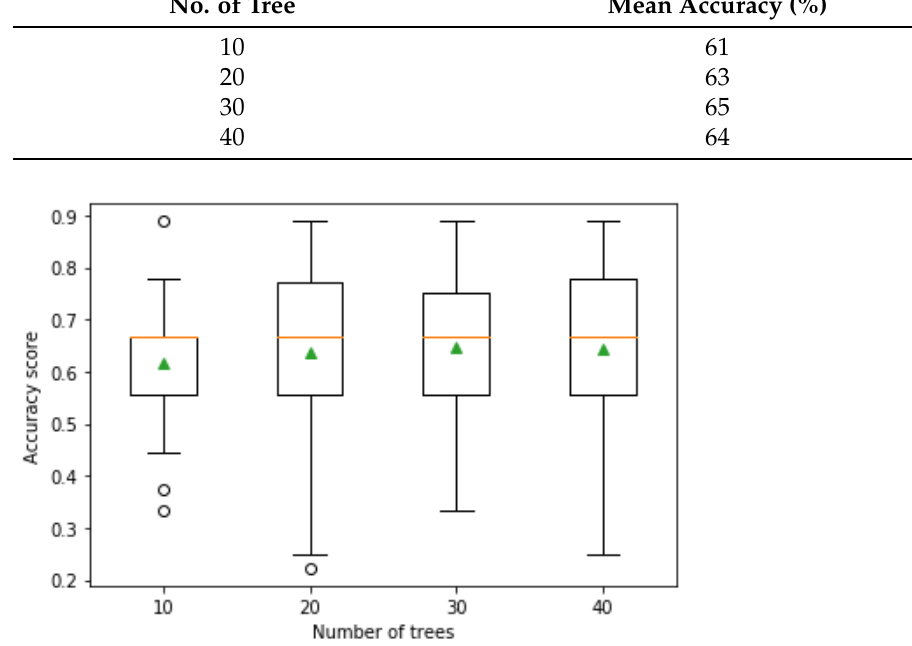
Figure 26. Pohang: Boxplot represents the mean accuracy distribution achieved by tuning the number of trees for every